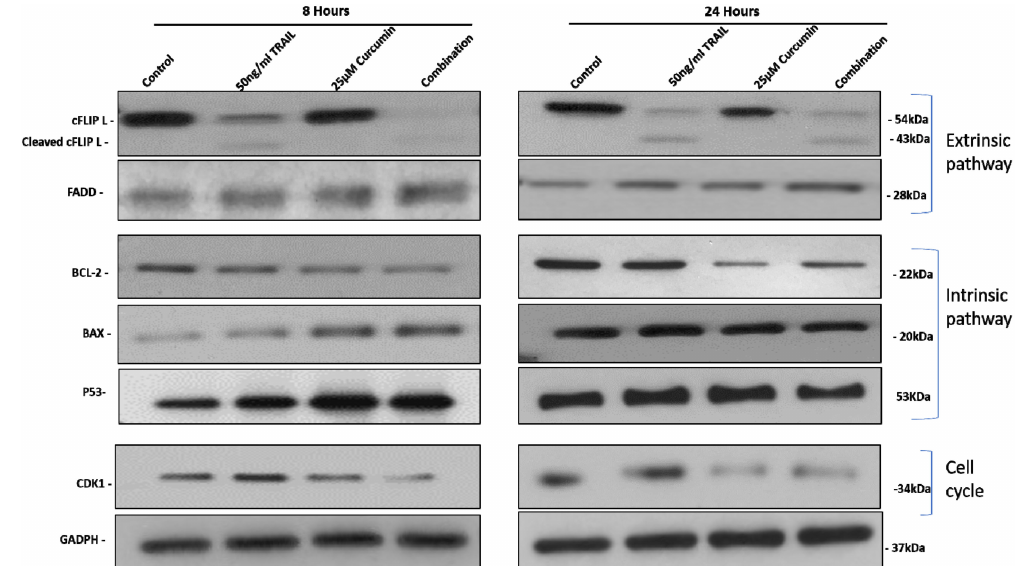
Figure 6. The e ff ect of curcumin, TRAIL, and curcumin / TRAIL combination on the expression of pro-and anti-apoptotic target proteins in ACHN cells. Cells were cultured on six-well plates and treated with vehicle control, 50 ng / mL TRAIL, 25 µ M curcumin or 50 ng / mL TRAIL / 25 µ M curcumin combination treatment. After exposure for 8- and 24-h whole cell lysates were prepared with RIPA bu ff er. Equal amounts of proteins were separated by SDS-PAGE electrophoresis, transferred to nitrocellulose and indirectly probed for (Bax, BCL-2, P53, FADD, cFLIP and CDK1primary antibodies. GAPDH was employed as a loading control. A representative blot is shown from three independent